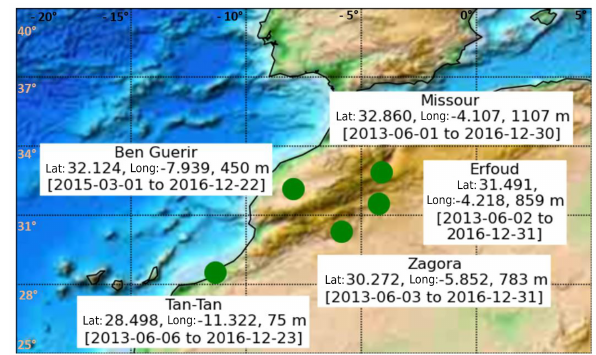
Figure 1. Geographical locations, coordinates, and period of mea- surements of the five